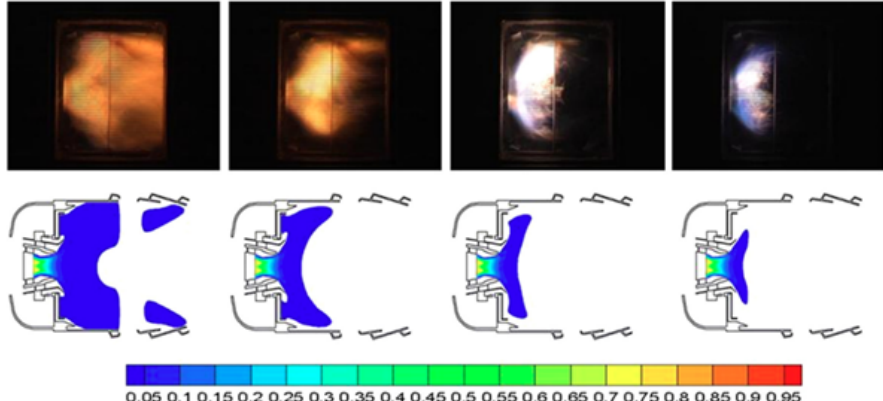
Figure 11. Comparison of FV simulation and experimental results